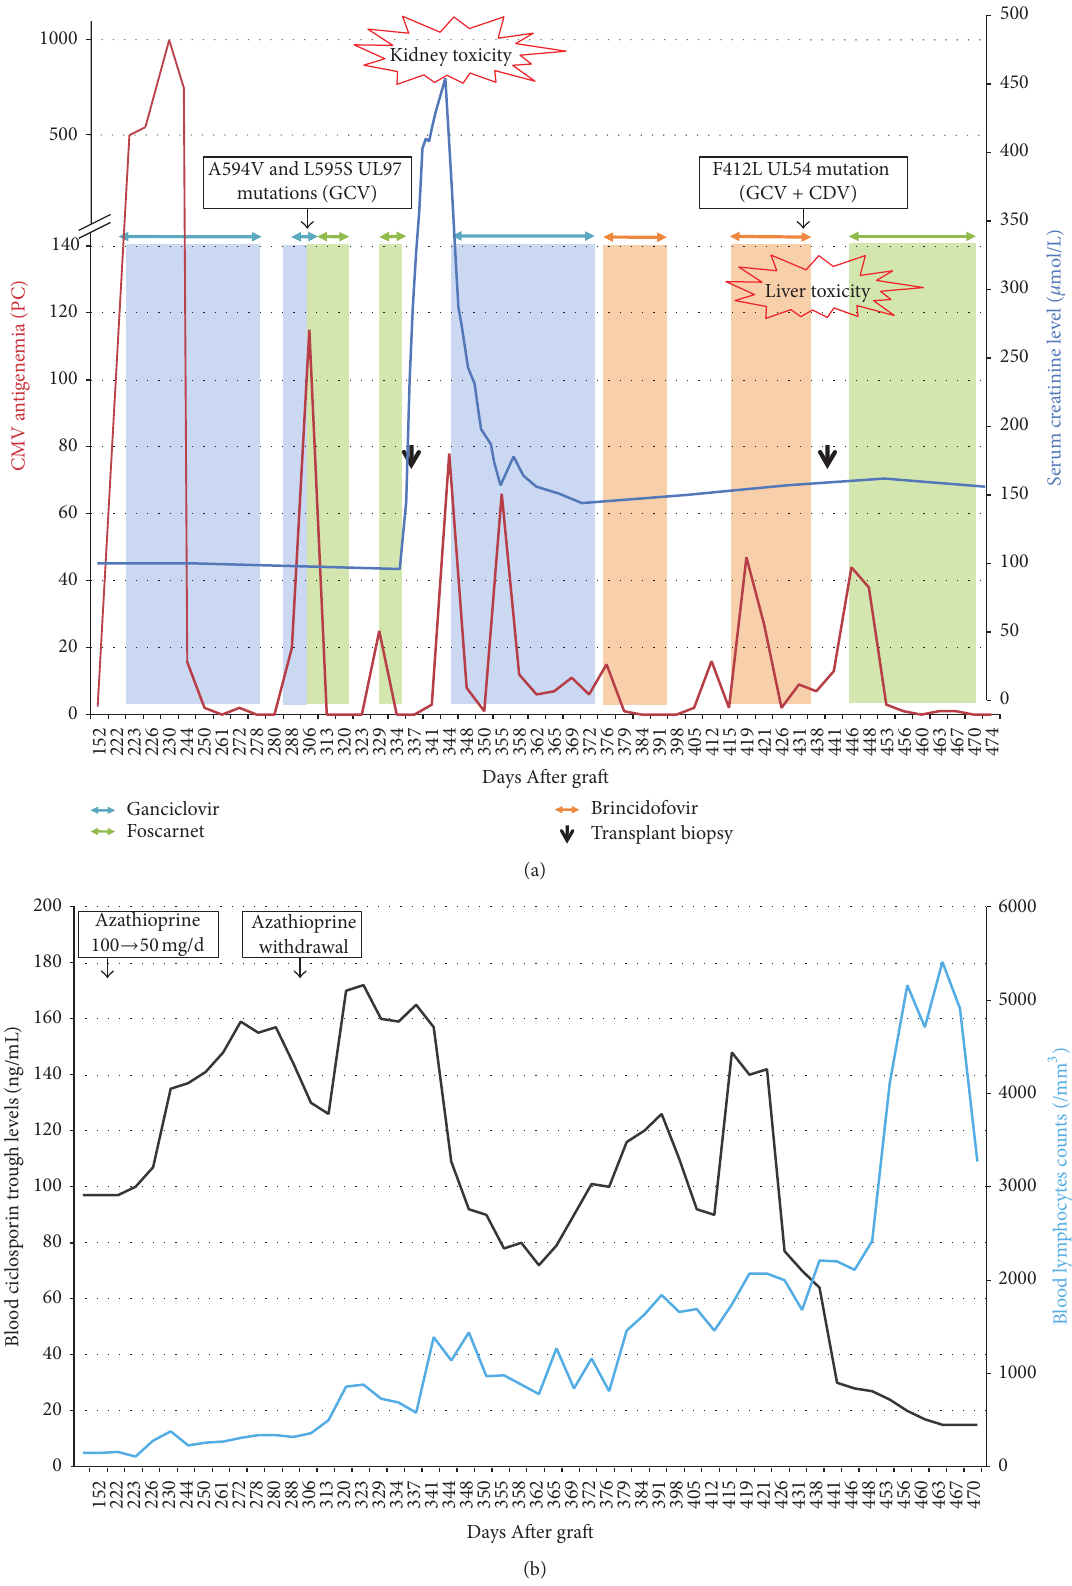
Figure 2: Course of multiresistant CMV disease. (a) Evolution of CMV antigenemia (red line) and kidney transplant function (serum creatininelevel,blueline)togetherwithantiviraltherapiesandgenotypicmutations.PC:positivecells/200000polymorphonuclearleukocytes. GCV: ganciclovir. CDV: cidofovir. (b) Evolution of blood ciclosporin levels (black line) and lymphocytes counts (blue